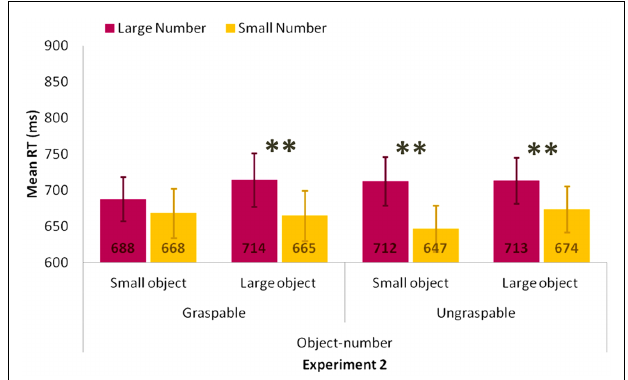
FIGURE 4 | Significant Order × Object type × Object size × Numerical magnitude interaction for RTs in the object–number condition of Experiment 2. Values are in millisecond and bars are SEM. Significant comparisons are indicated with *(p < 0.05) or **(p <